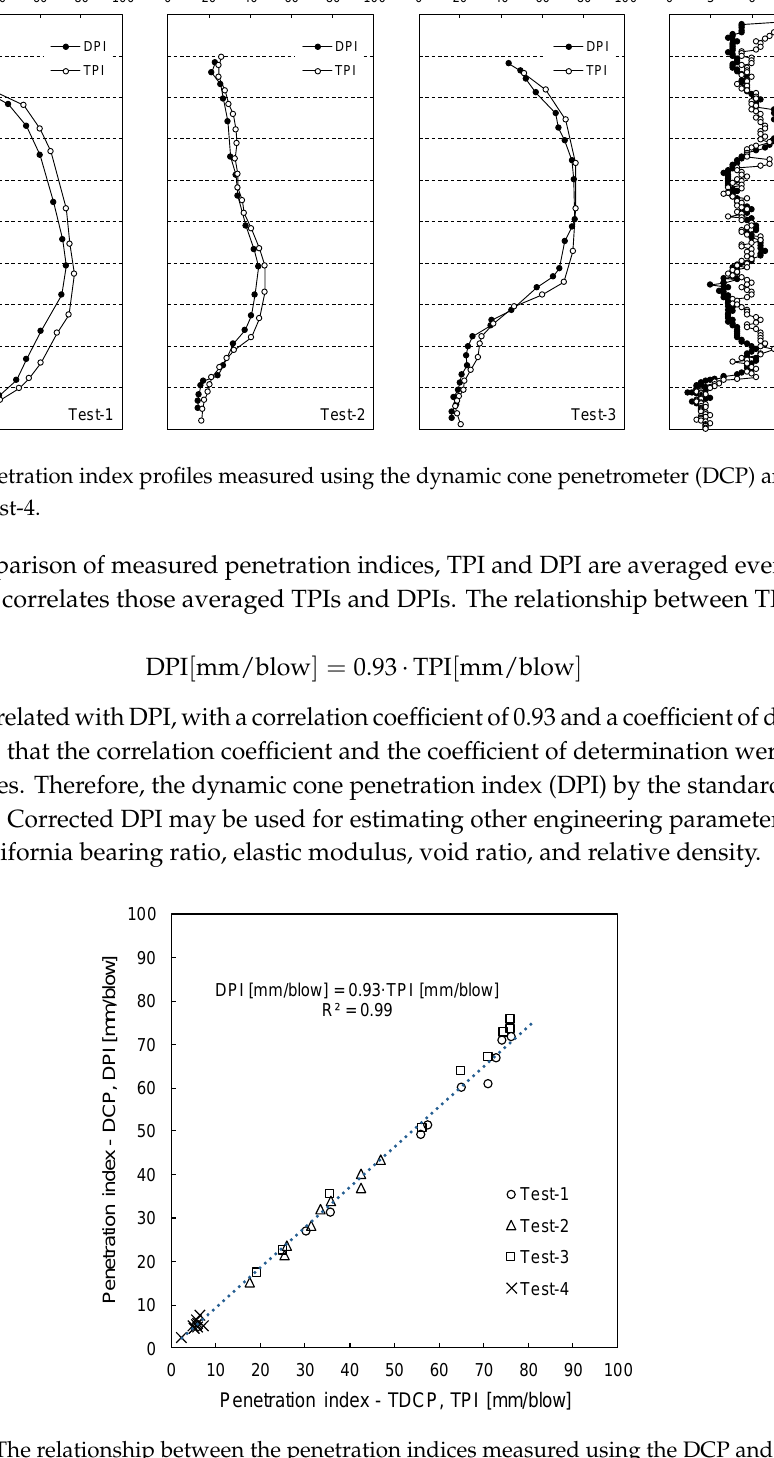
Figure 10. The relationship between the penetration indices measured using the DCP and TDCP.